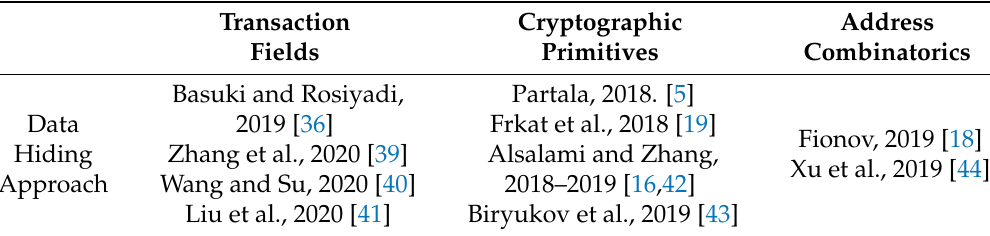
Table 2. Summary of data hiding approaches for blockchains accordingly to the cover